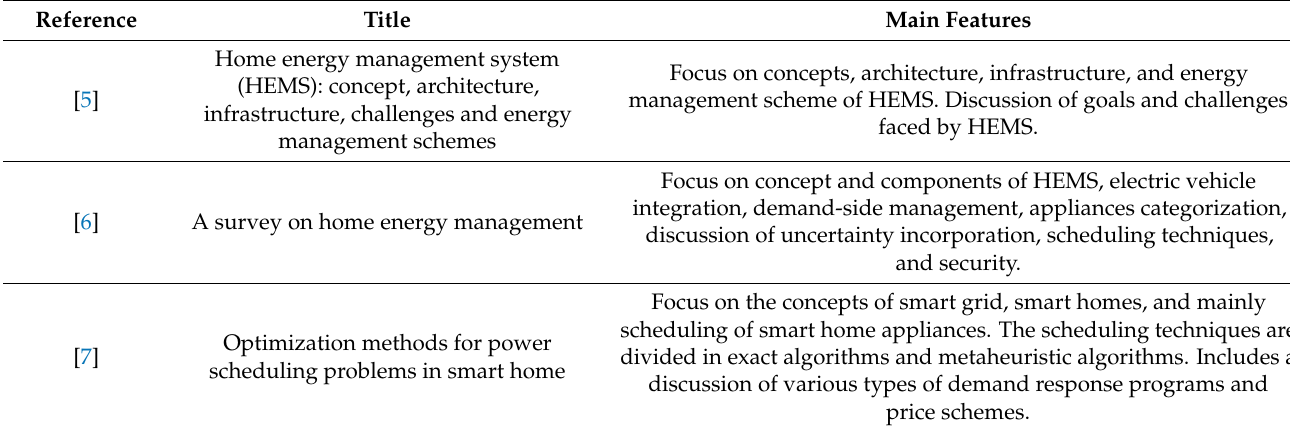
Table 2. Review articles and main features since